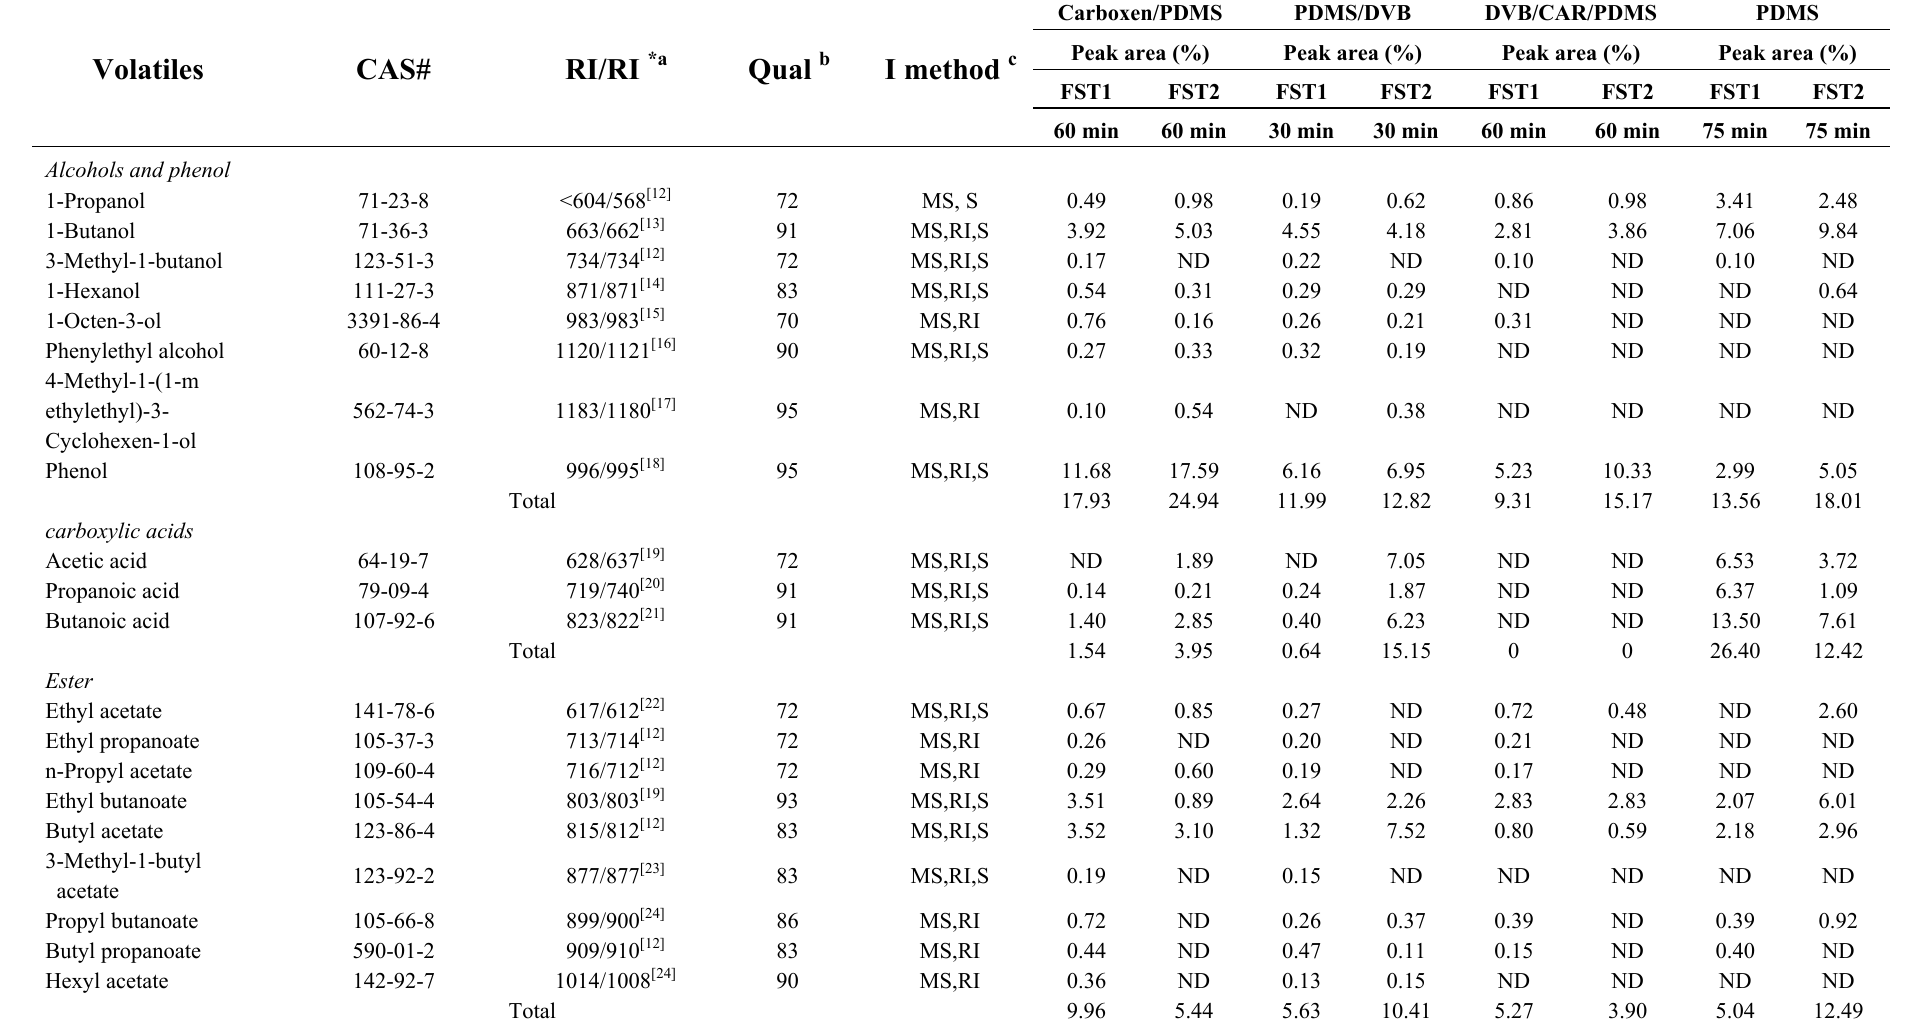
Table 2. Identification of organic volatile flavor compounds in FST1 and FST2 using